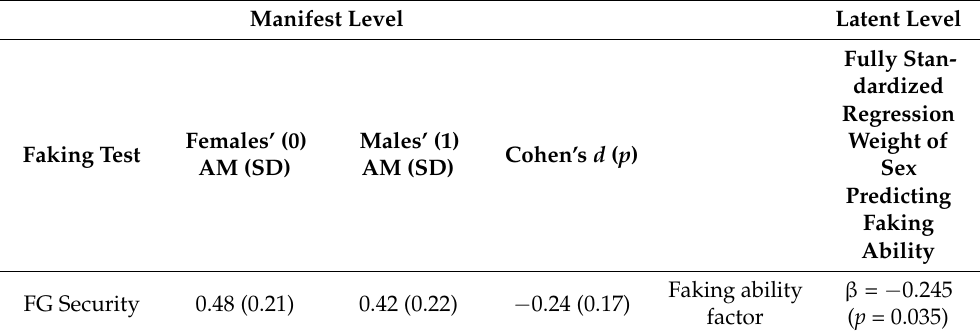
Table A3. Sex differences in faking